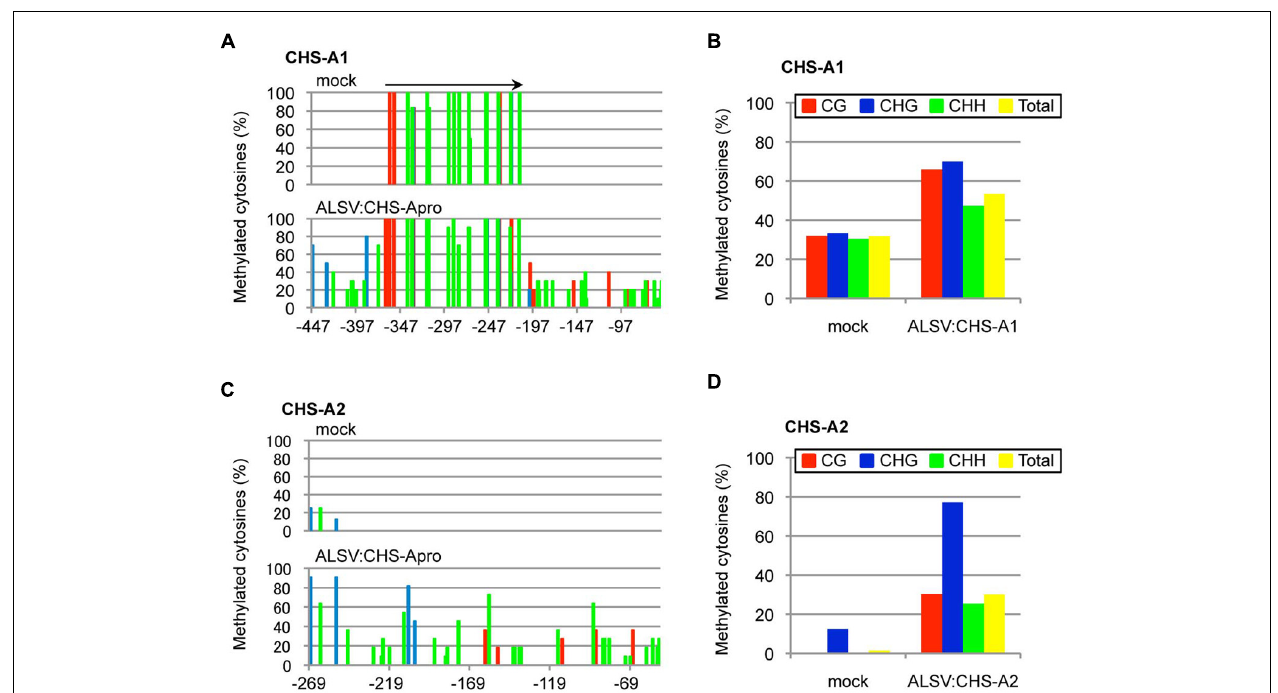
FIGURE 6 | Cytosine methylation status of the promoter of CHS-A1 and CHS-A2 . Total DNA was extracted from mock-agroinoculated petunia plants and from plants infected with ALSV:CHS-Apro and treated with bisulfite. The red, blue, and green bars respectively represent the percentage of cytosines methylated at the CG, CHG, and CHH sites.